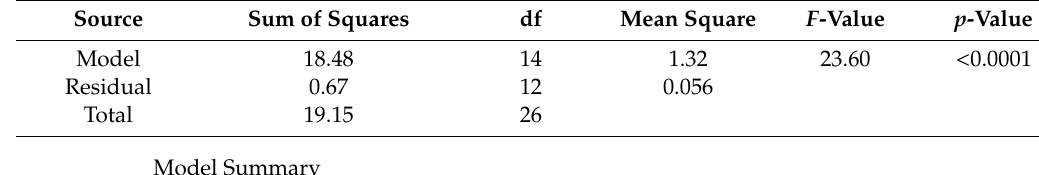
Table 4. Analysis of variance (ANOVA) for the fitted models.